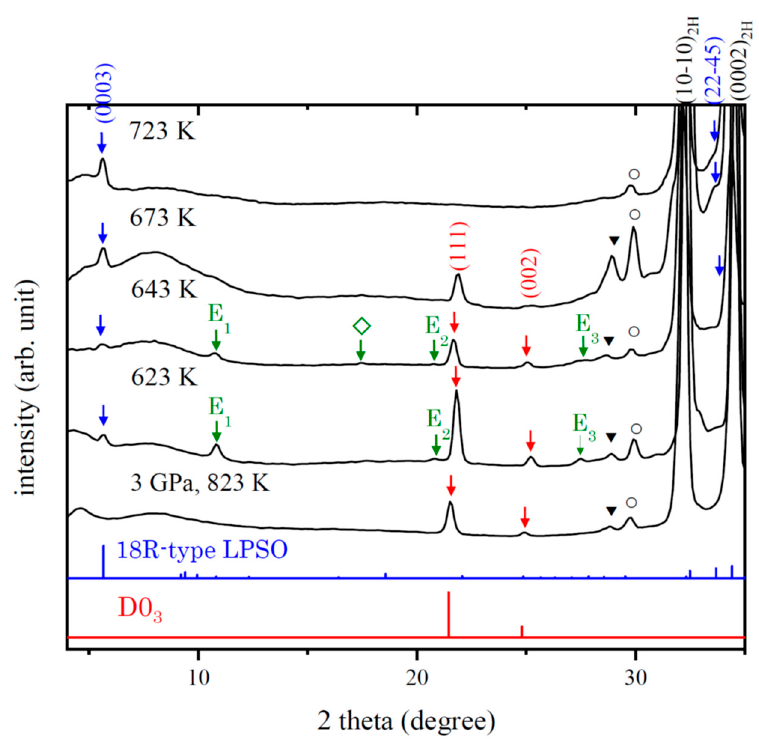
Figure 3. X-ray diffraction patterns of the Mg 97 Zn 1 Y 2 alloy, which had been annealed at 3 GPa and 823 K for 2 h, and subsequently annealed for 10 min at various temperatures in ambient pressure. The blue and red lines show the estimated peak position and intensity from the 18R-type LPSO in Reference [5] and D0 3 in Table 1, respectively. The index and arrows in blue and red indicate coinciding peaks to 18R-type LPSO and D0 3 , respectively. The peaks from Y 2 O 3 and Y are indicated by a circle ( ) and triangle ( (cid:72) ), (cid:35)